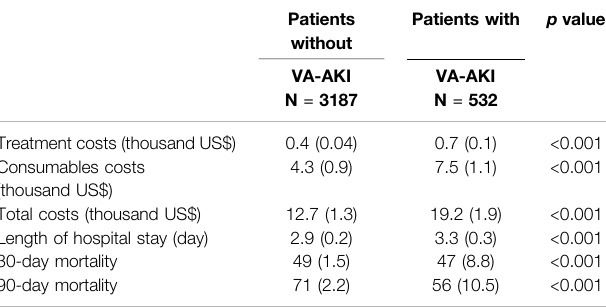
TABLE 4 | Medical costs and outcomes of patients with and without VA-AKI.